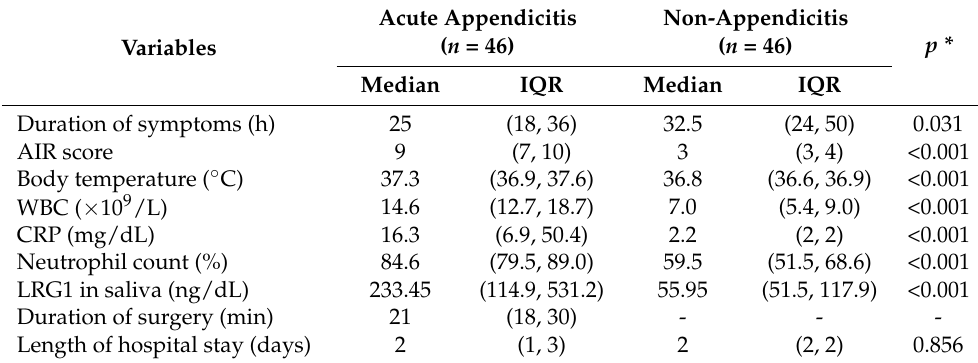
Table 3. Clinical and laboratory data of the